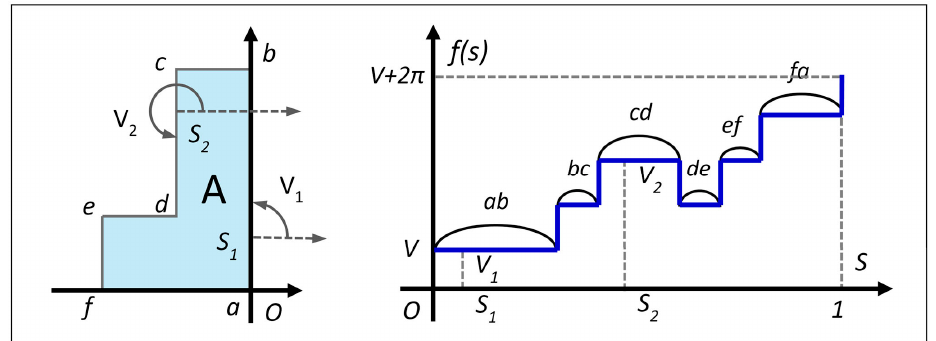
Figure 3. Defining the turning function f ( s ) of polygon